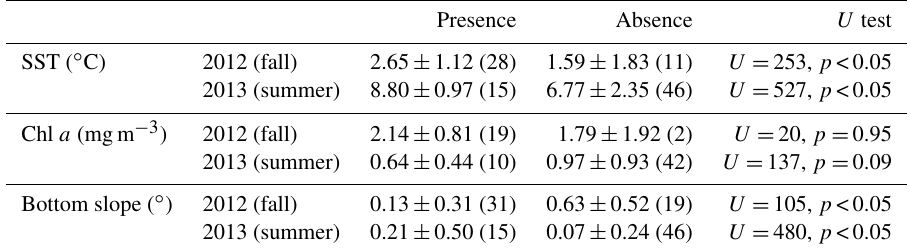
Table 4. Differences in the explanatory variables between the 50km 2 grids with and without short-tailed shearwaters ( Ardenna tenuirostris ) during fall (September) 2012 in the Chukchi Sea and summer (June–July) 2013 in the Bering and Chukchi seas. Values are means ± SD, with sample sizes in parentheses. The results of Mann–Whitney U tests are also shown.